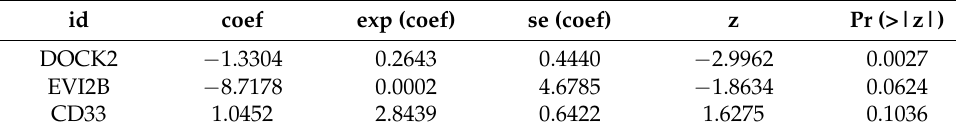
Table 1. Multivariate cox regression analysis of three key